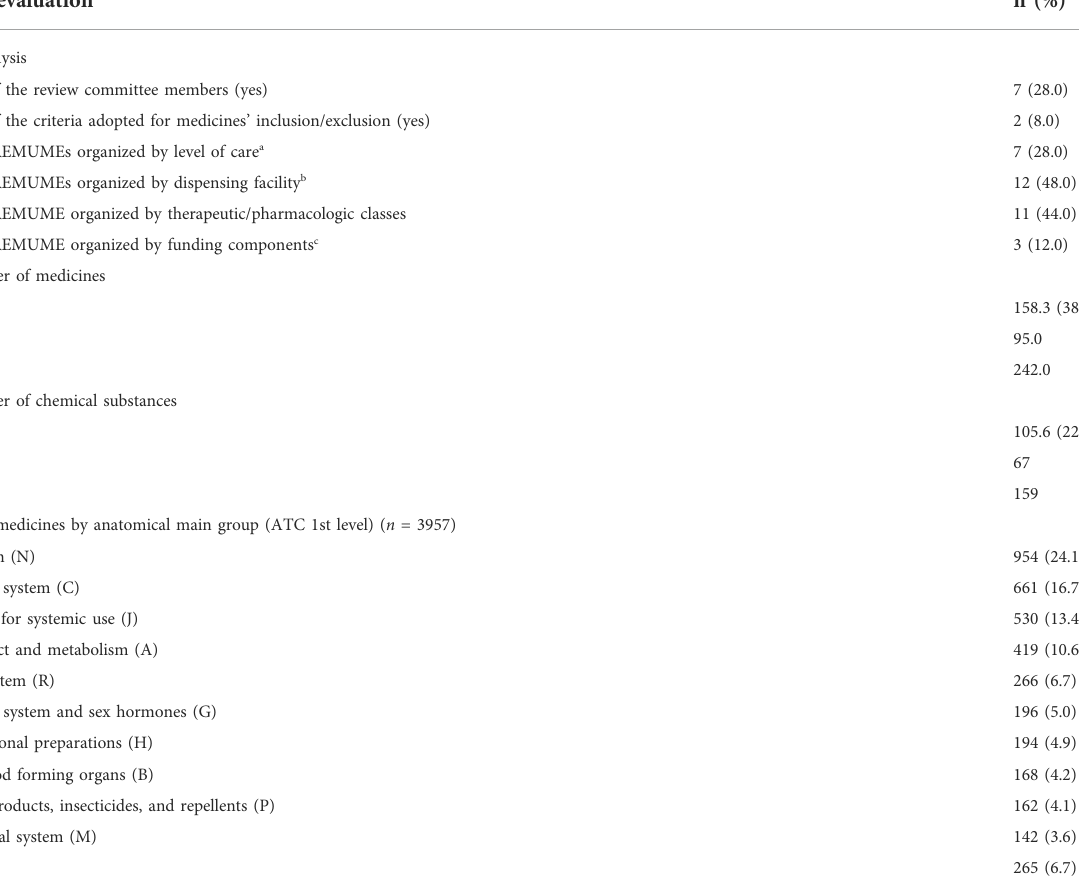
TABLE2FindingsfromtheMunicipalListsofEssentialMedicines(REMUME)evaluation inaccordancewiththedocumentanalysis.MedMinasProject,